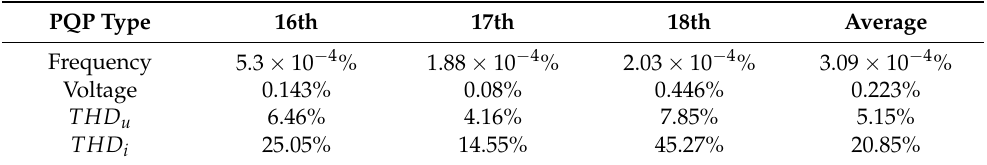
Table 6. Forecasting error (MAPE in %) for 16–18 August 2021, when using ANN with two hidden layers and 20 neurons in each layer.